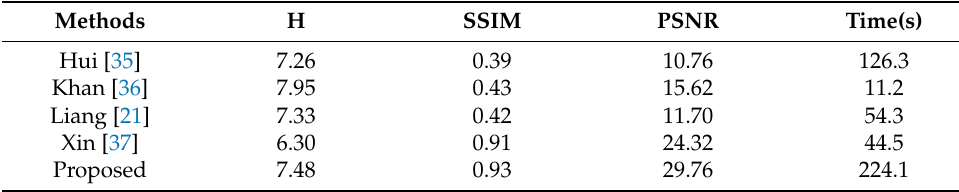
Table 4. Objective values of the images shown in Figure 7.